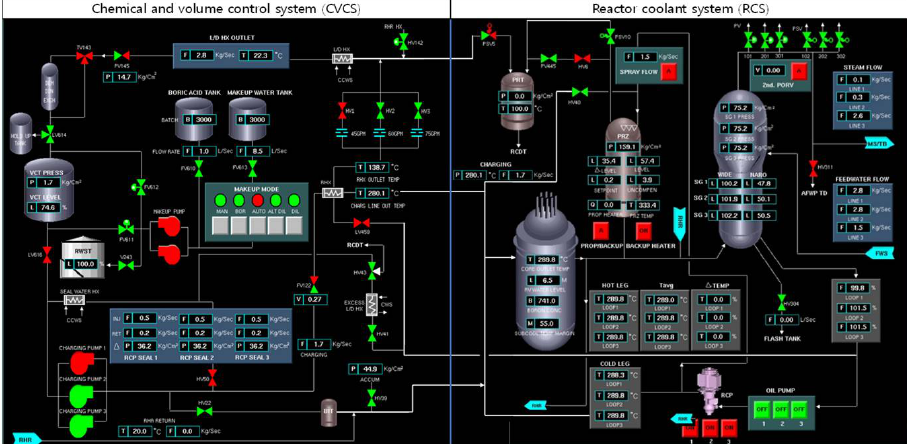
Figure 10. Chemical and volume control system (CVCS) and reactor coolant system (RCS) in the CNS.